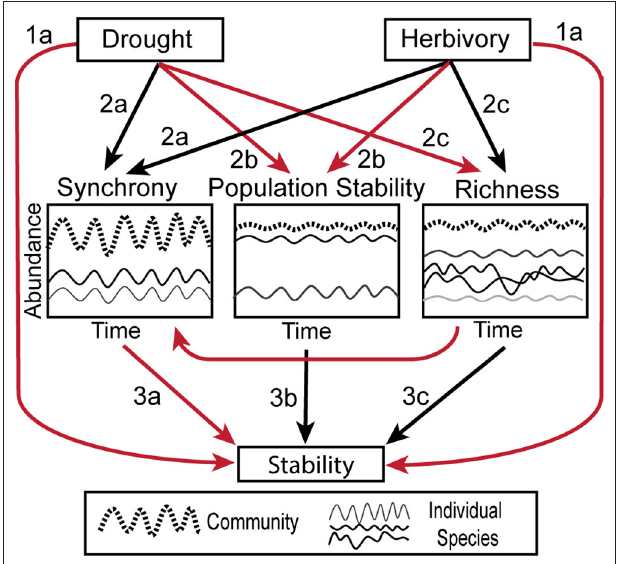
FIGURE 1 | Conceptual figure illustrating the hypothesized relationships between herbivory, drought, biotic stability mechanisms and temporal stability. Black arrows indicate positive relationships, while red arrows indicate negative. Compare to Figure 6 . The biotic mechanisms are illustrated as follows: Synchrony—two individual species’ abundances (thin solid lines) fluctuate in unison, causing the full community (thick dashed line) to be more variable. Population Stability–one of the two individual species is dominant compared to the other (thin solid lines) and the population stability of the dominant species heavily influences the stability of the overall community (thick dashed line). Richness—when a community is composed of many species (thin solid lines), they average out to make the full community (thick dashed line) more stable than the individual